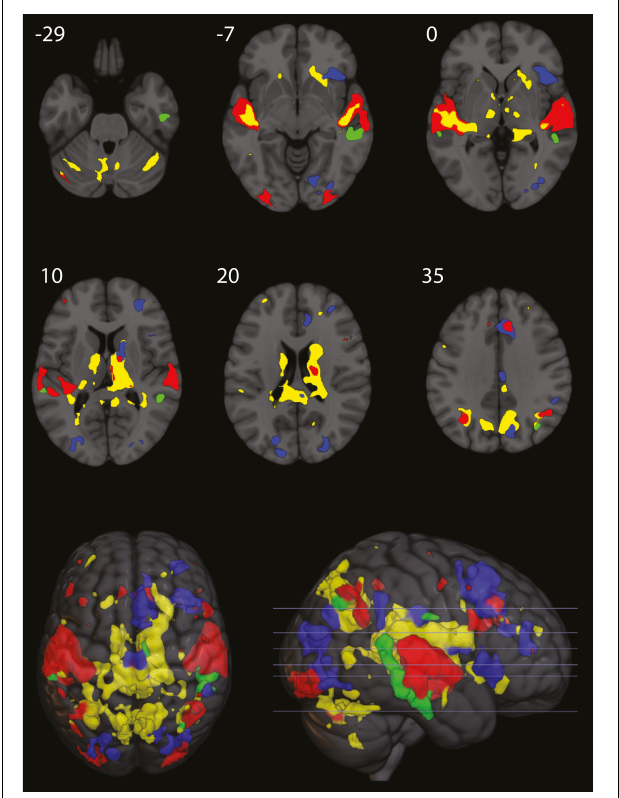
areas, where activity decreased in the last 12 s, compared to the first 4 s of listening. Blue areas, persistent activity for the remaining 88 s of listening (only for epochs of normal presentation of the rhythm). Green areas, beat omission activity in the middle temporal gyrus. Numbers refer to MNI coordinate on the axial plane (figure made partly with MRIcroGL, with small cluster